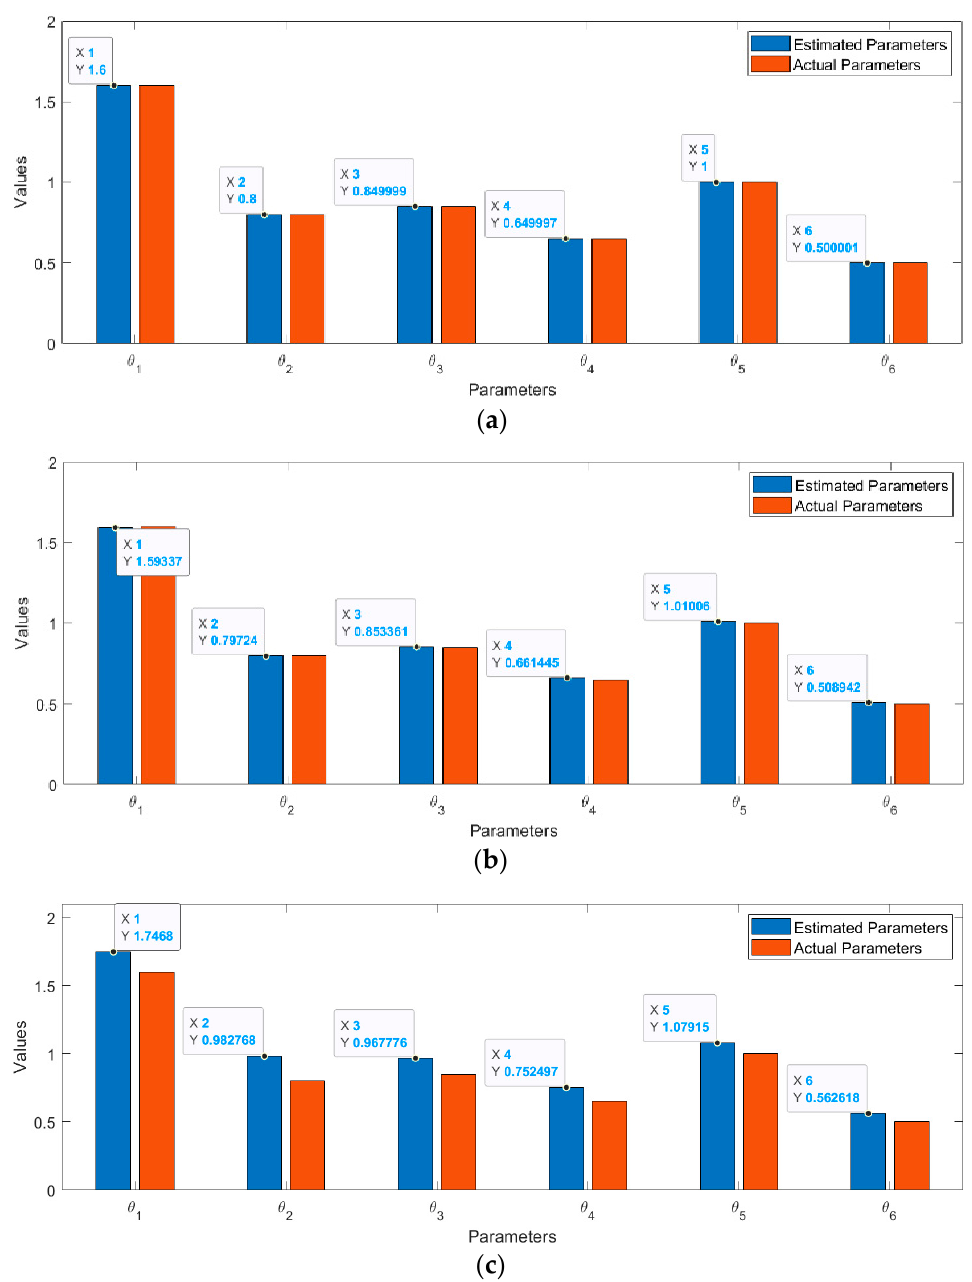
Figure 9. Results of estimated parameters in comparison with actual HC-AR parameters considered in Problem 1. ( a ) MSE through estimated responses ( b ) MSE through estimated parameters ( c ) Normalized parameter deviation